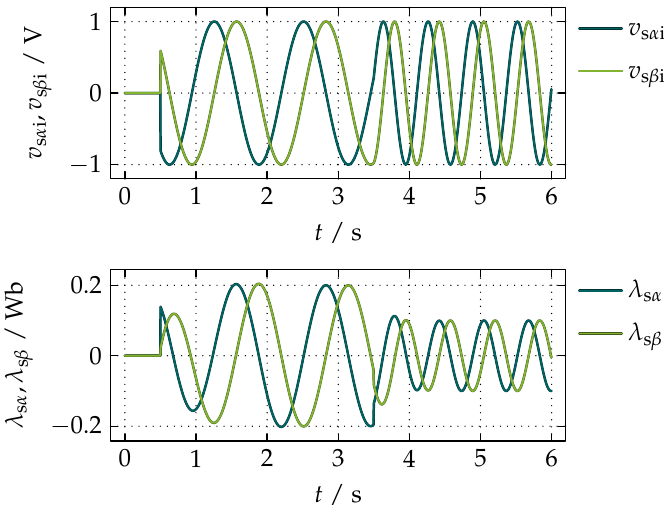
Figure 11. Simulation results of the proposed compensation of the integrational drift for a step in ω e from 5 rad/s to 10 rad/s, and constant amplitudes of v s α i and v s β i after the initial time of 0.5